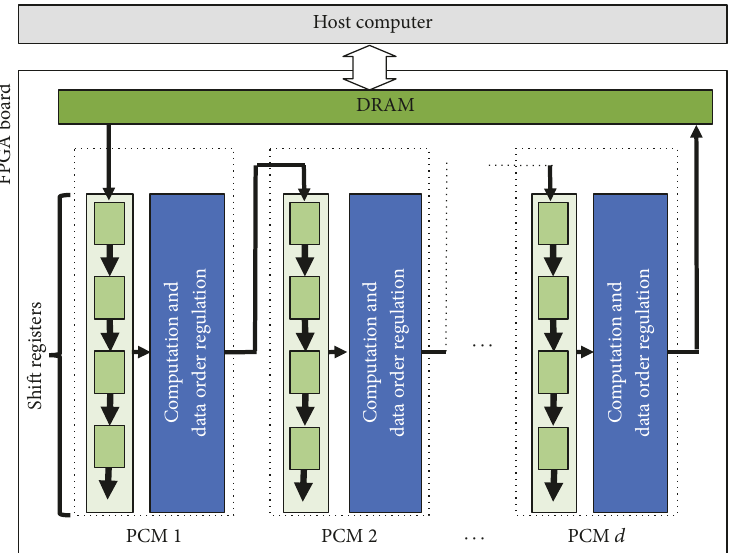
Figure 8: Architecture of the proposed FPGA accelerator. Iteration-parallel computation is achieved by processing 𝑑 iterations in parallel. ssn[i][j][k] to determine ssn at 𝑥 direction (ssnx) . Similar process is applied to compute ssny and ssnz also, as shown in Listing 2. Note that arrays ssnx , ssny , and ssnz are used in the C-program to store the data of ssn 𝑥 , ssn 𝑦 , and ssn 𝑧 , respectively. Constants ssn 𝑥 , ssn 𝑦 , and ssn 𝑧 are the ssn values of 𝑥 , 𝑦 , and 𝑧 directions,